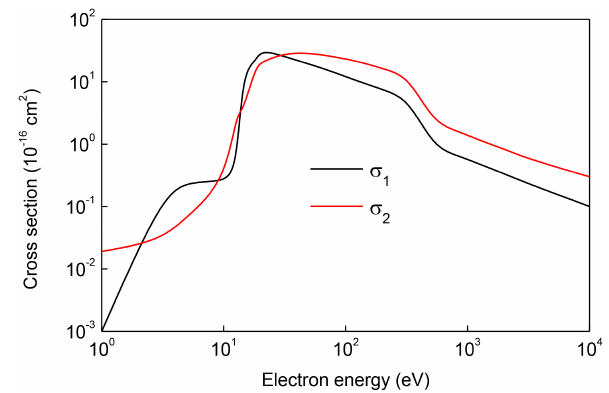
Figure 5. Electron impact excitation cross sections versus electron energy for dissociation ( σ d ) and direct atomic O ( 5 S ◦ ) and direct atomic O ( 5 P ) excitations. Atomic O ( 5 P ) cascades into O ( 5 S ◦ )